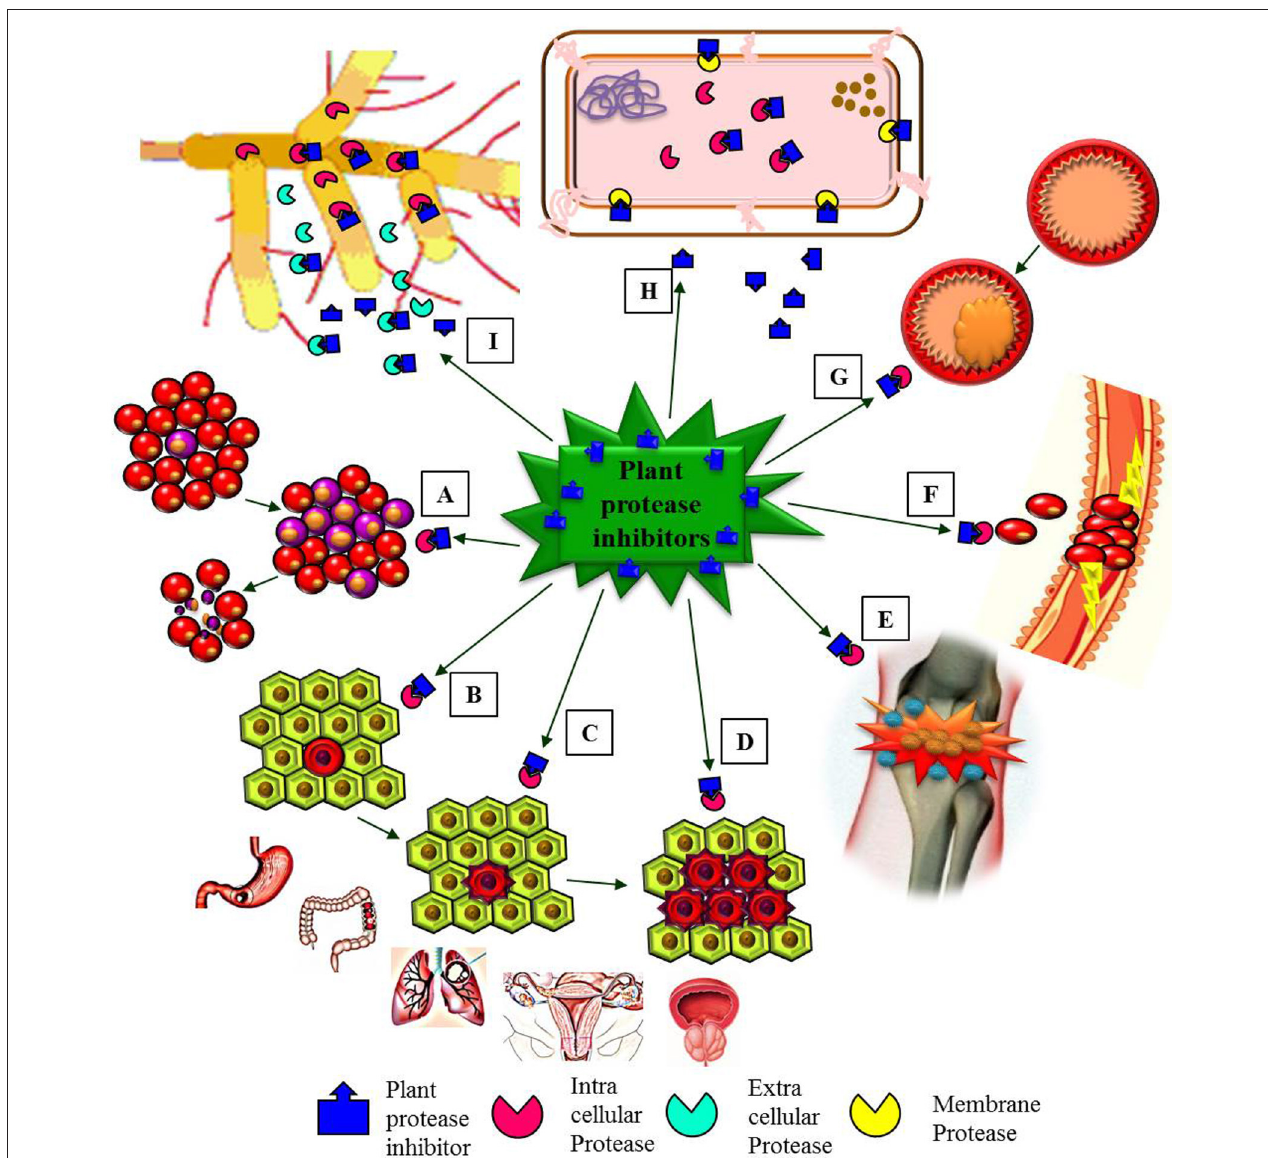
FIGURE 5 | Schematic representation emphasizing major pharmacological effects of plant protease inhibitors (PPIs). (A) PPIs induces apoptosis of leukemia cells (healthy red blood cells and leukemia blood cells). (B–D) PPIs showed in vitro anti-carcinogenic effects in initiation (B) , proliferation (C) , and progression (D) stages of different types of cancers (gastric, colon, lung, ovarian, and prostate cancers). (E) PPIs as anti-inflammatory agents. (F) The role of PPIs as anti-coagulant. (G) PPIs active against cardiovascular diseases (plaque formation in a blood vessel). (H) Antibacterial activity of PPIs. (I) . Antifungal activity of PPIs.